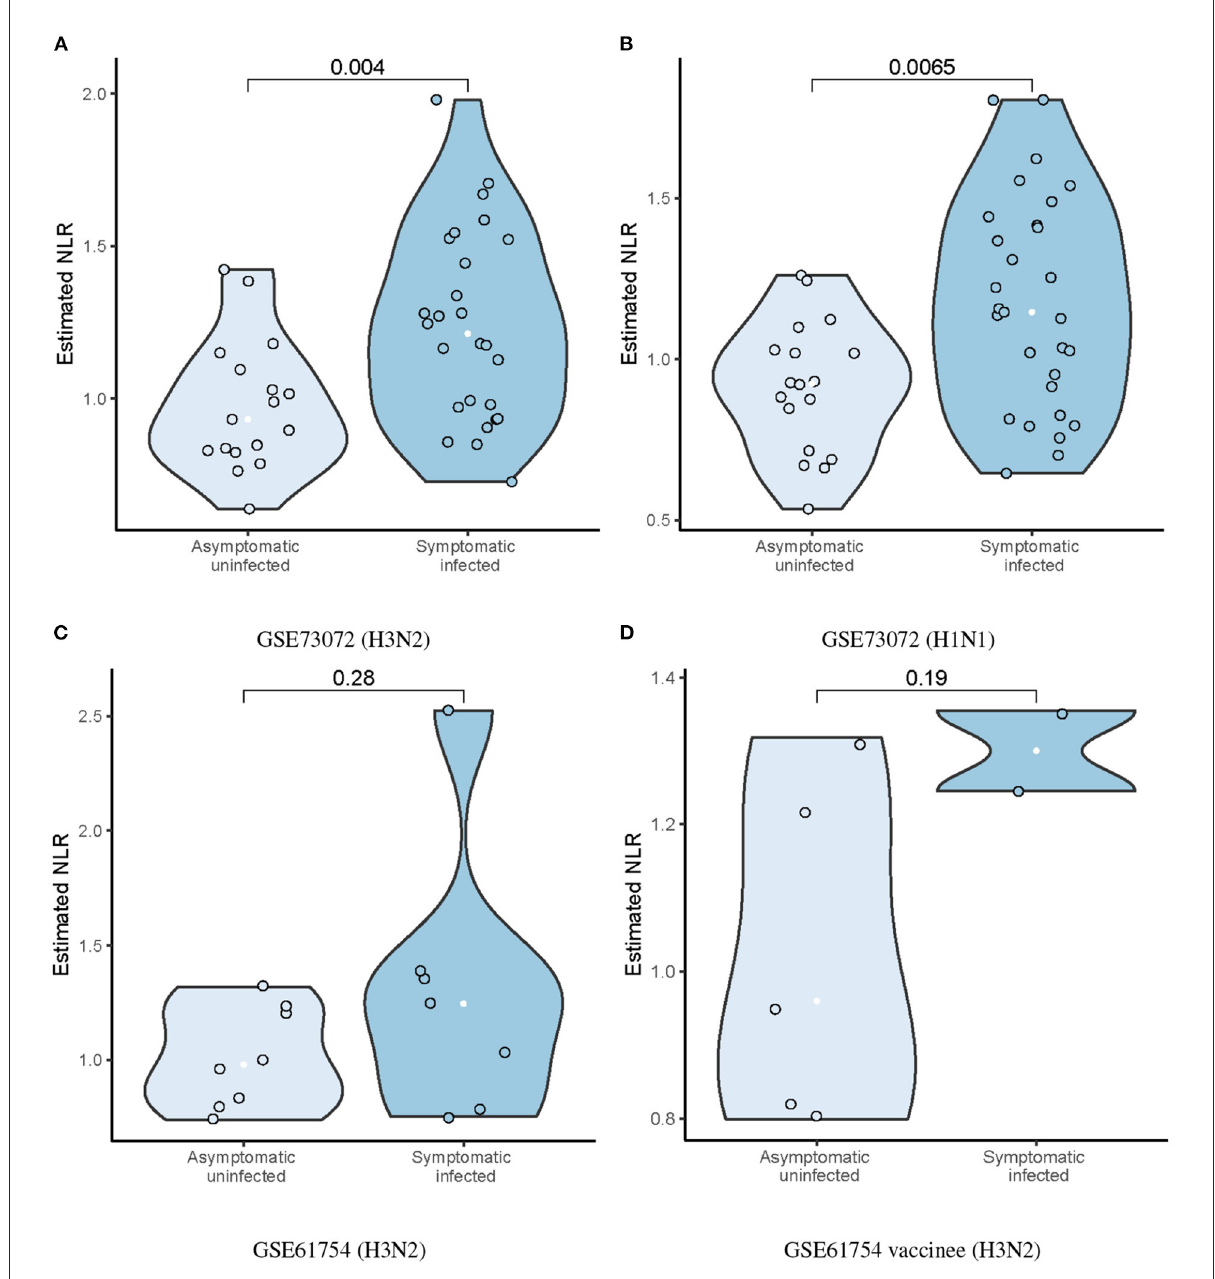
FIGURE4 Differences in estimated baseline NLR between AU and SI groups in the discovery (A) and validation cohorts (B–D) .